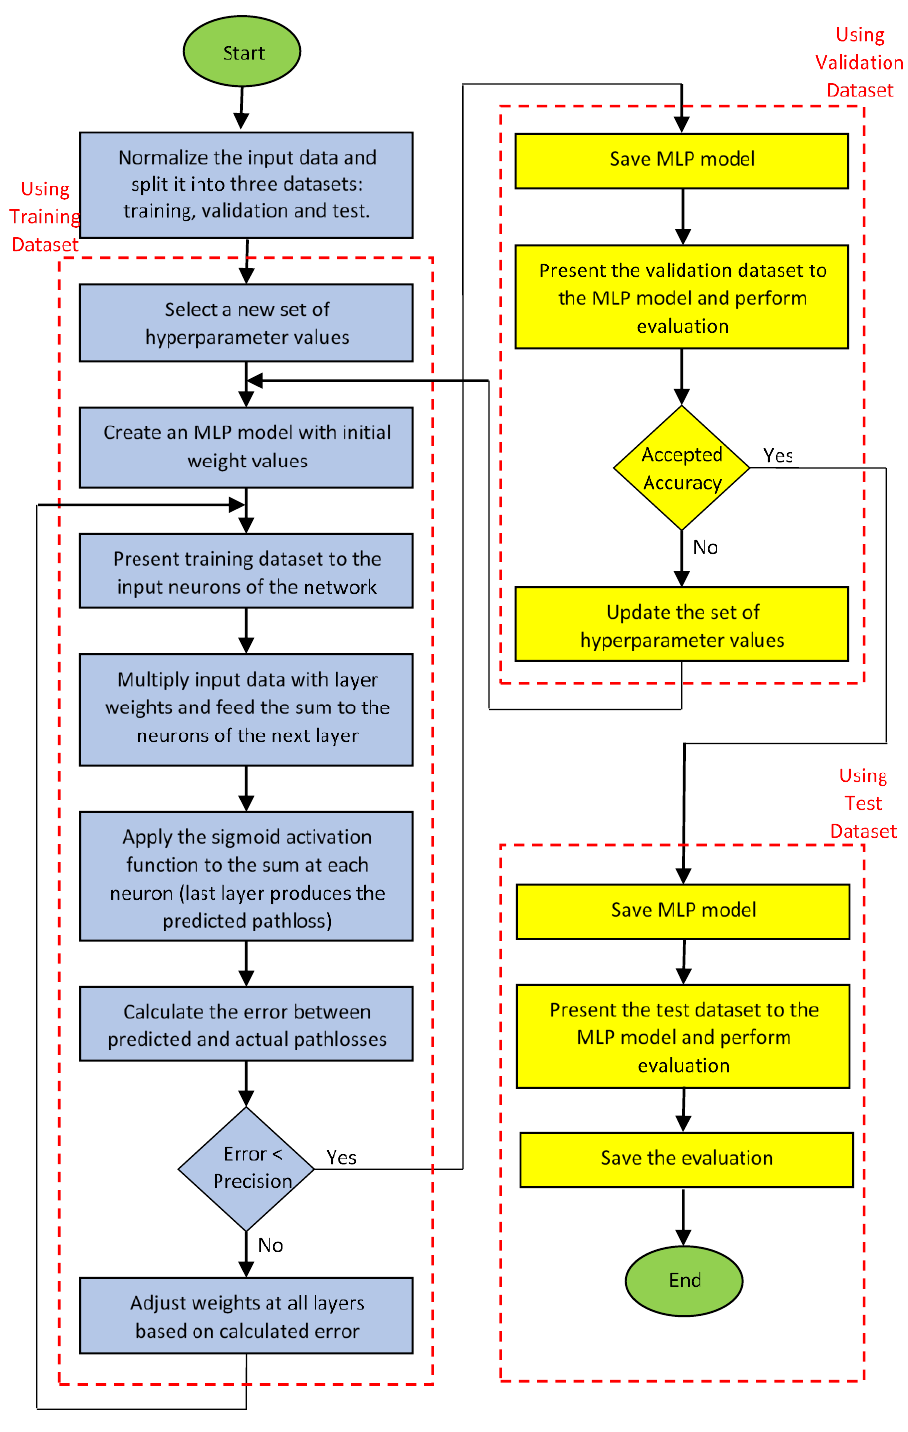
Figure 3. Flowchart of proposed predictive modelling with MLP neural network.